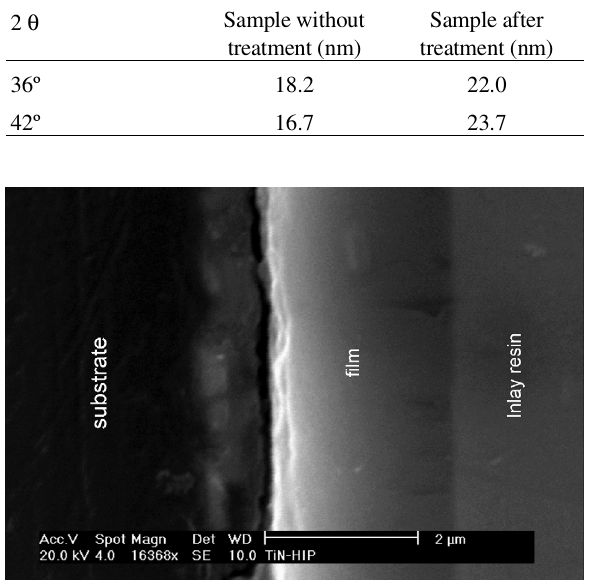
Figure5. MicrographofaTiNfilmaftertheHIPtreatment.Backscattered electron image.